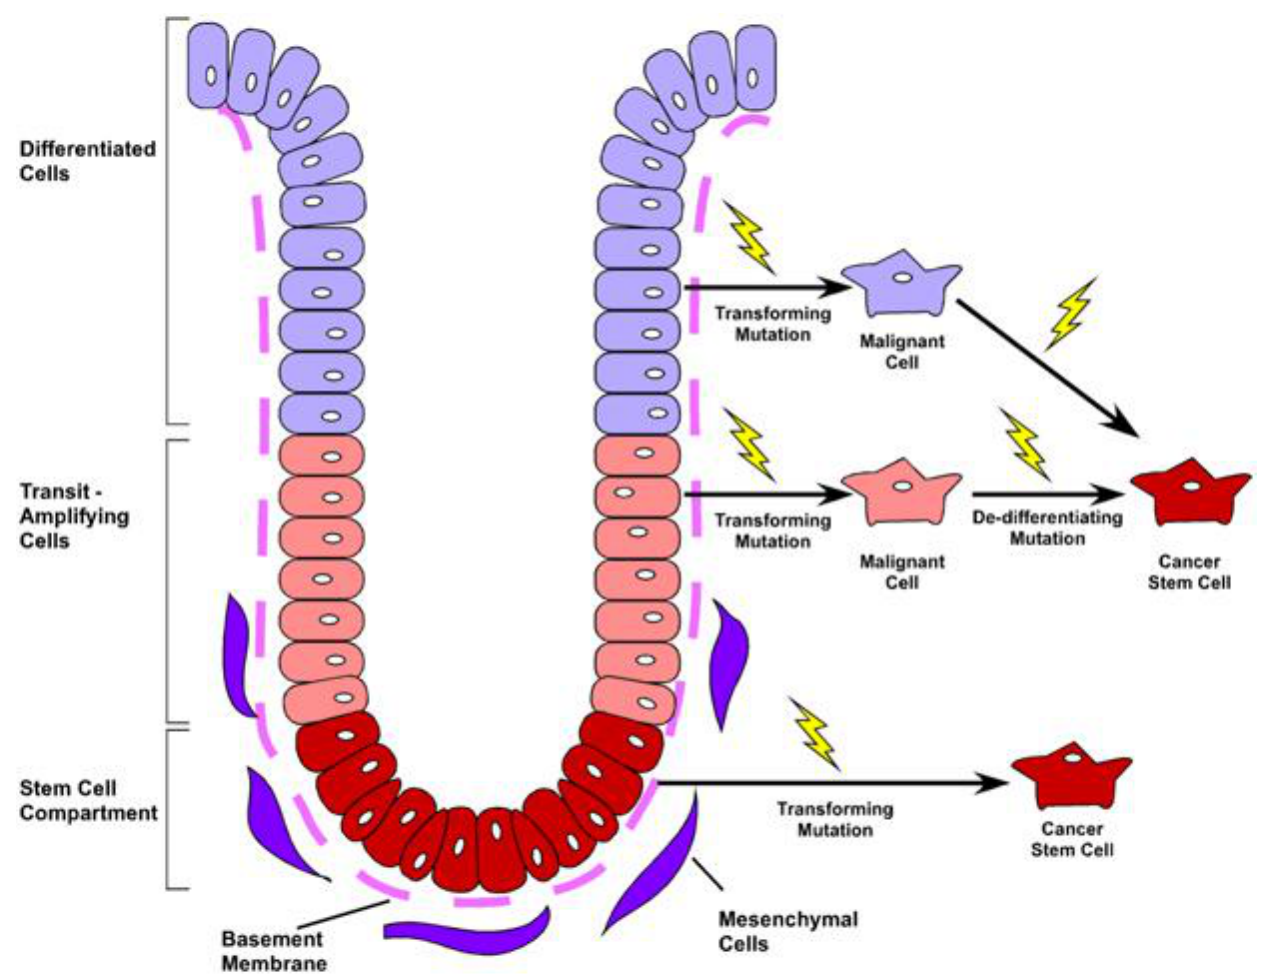
resides at the base of the crypt. Rapidly dividing transit-amplifying (TA) cells arise from this population and differentiate into the functional cells of the colon. (Right) The source of the colon CSC remains controversial. A single transforming mutation in a somatic intestinal stem cell could give rise to a CSC, while two mutations (one transforming and one de-differentiating) would be required to change a TA or differentiated colonic cell into a